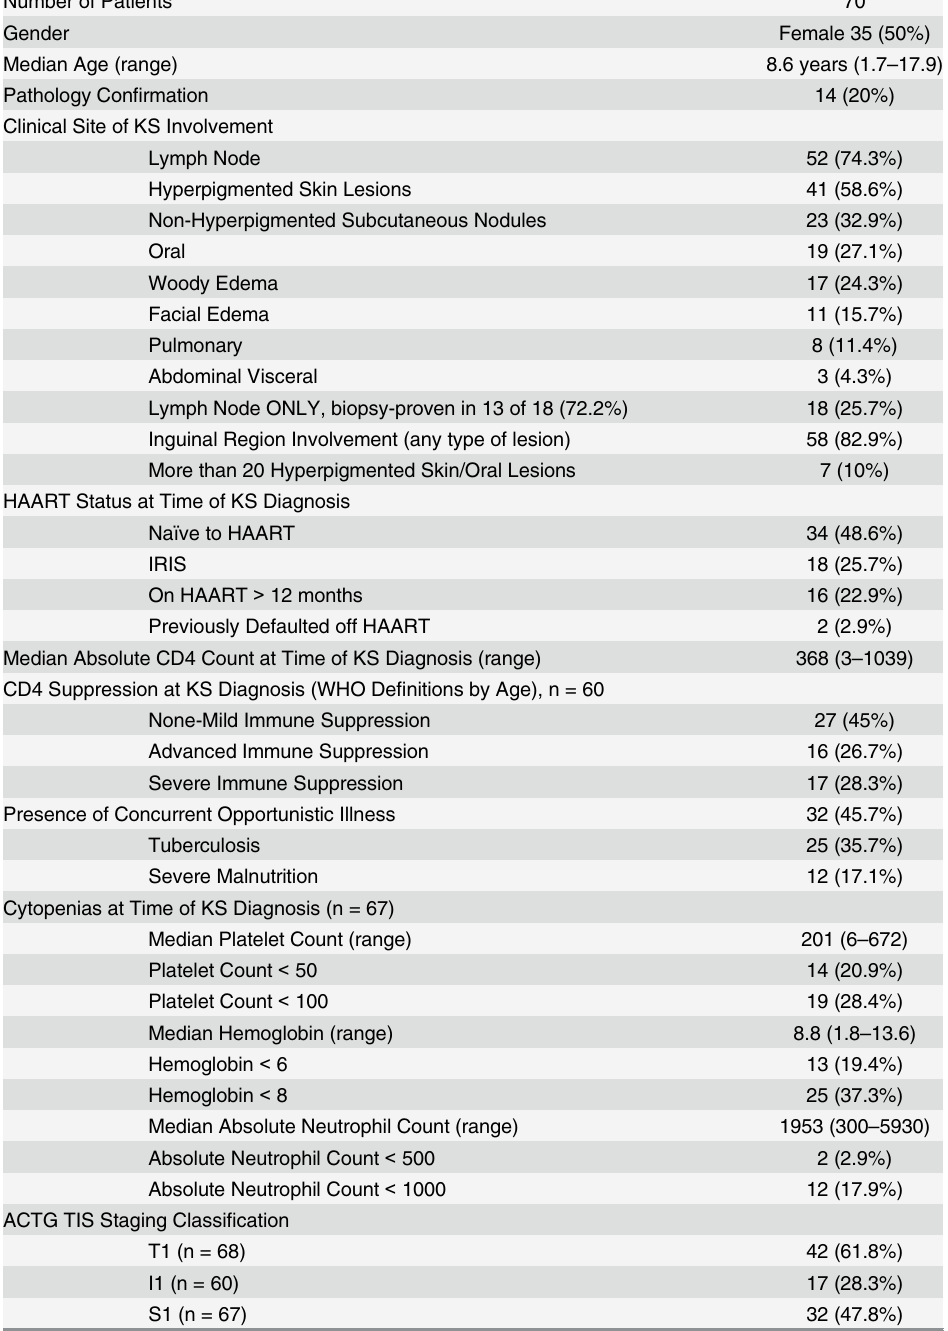
Table 1. Clinical Characteristics of HIV-infected Children and Adolescents with Kaposi